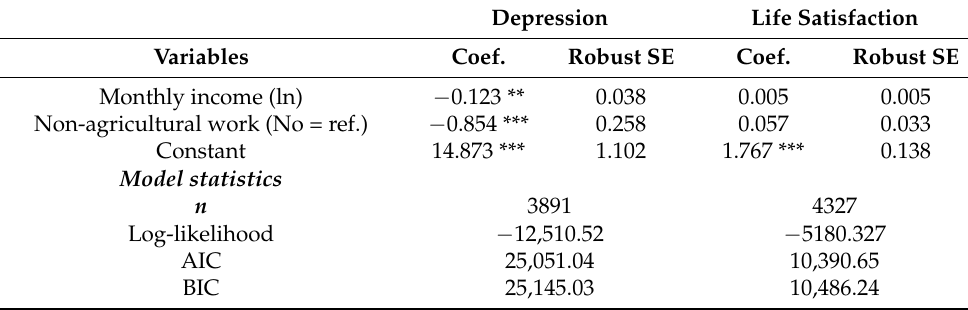
Depression Life Satisfaction